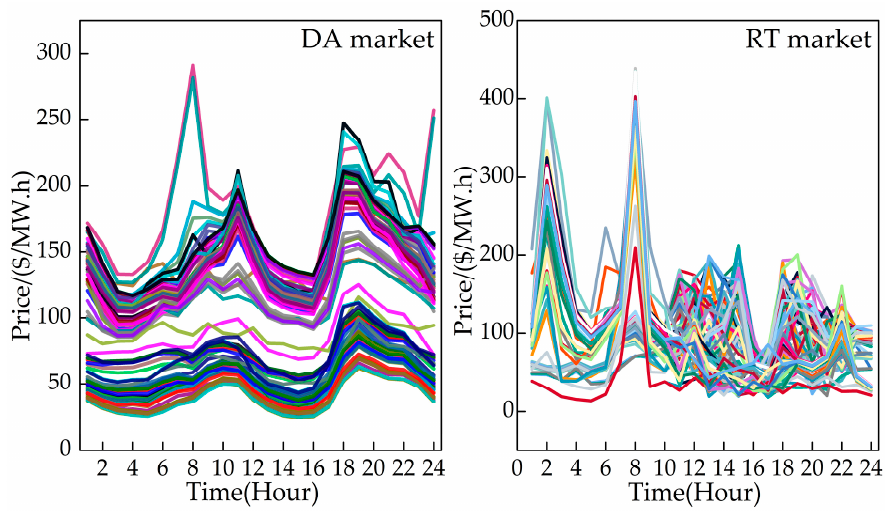
Figure 5. Scenario prices of the day-ahead (DA) and real-time (RT) market. Table 1. Parameters of the Diesel generation and energy storage system (ESS).